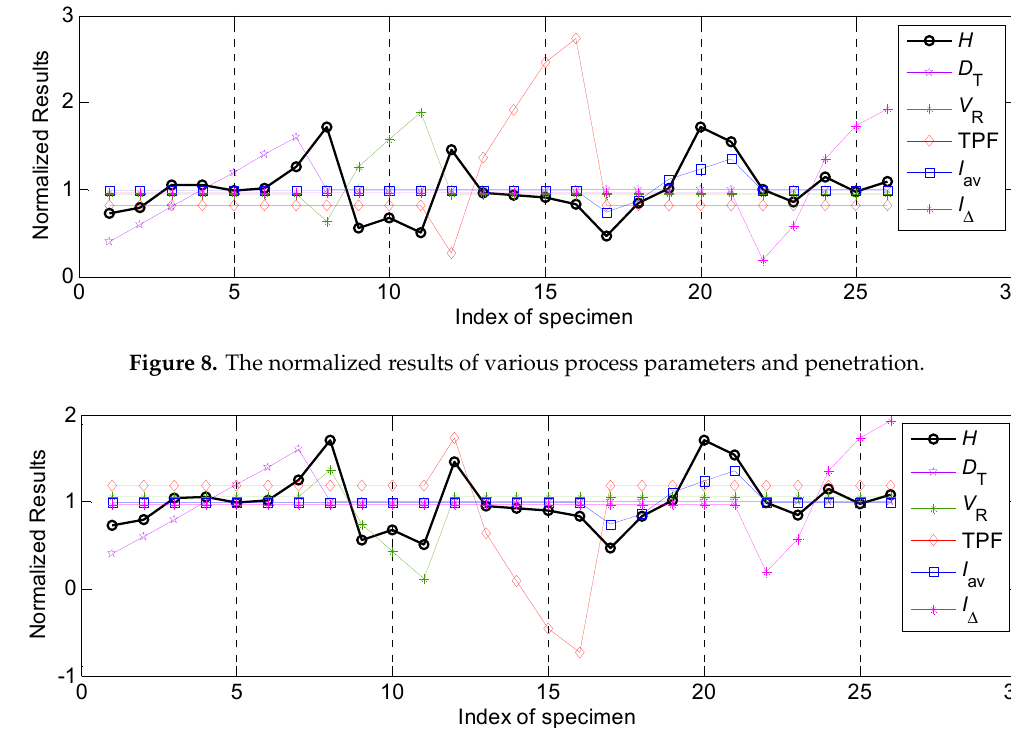
transformation for special parameters.